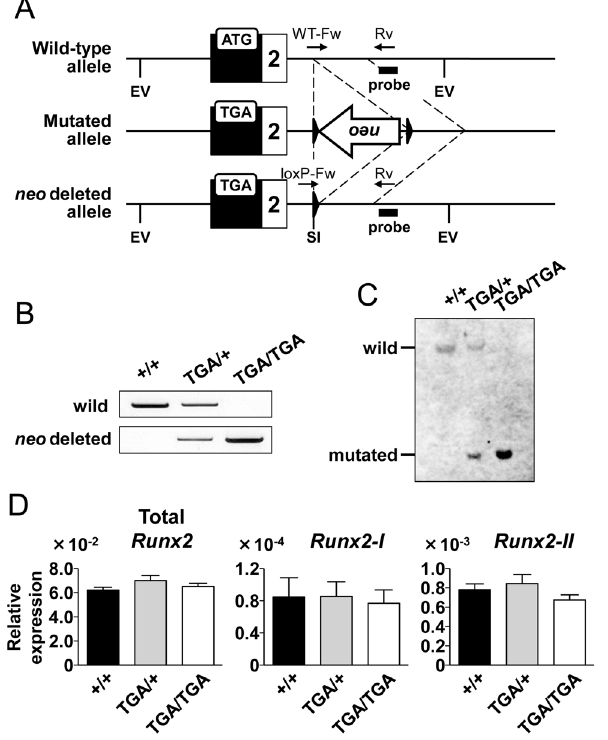
Figure 4. The lethality in Runx2-I neo/neo mice was rescued by neo cassette deletion. Runx2-I neo/ + mice crossed with a Cre deleter mice to remove the neo cassette. (A) Schematic illustration of depletion of the neo cassette. Relevant Eco R V (EV) and Sal I (SI) recognition sites are indicated. (B) Deletion of the neo cassette was confirmed by PCR. The primers depicted in panel (A) were used to detect the wild-type allele (WT-Fw and Rv) and the neo -deleted allele (loxP-Fw and Rv). The PCR products were 1.1 kb in size for both the wild-type and the neo -deleted allele. + / + , wild-type; TGA/ + , heterozygous; TGA/TGA, homozygous. (C) Southern blot analysis using the genome of the indicated Runx2-I - targeted littermates after digestion by Eco R V and Sal I. The membrane was blotted with the probe shown in panel (A). The size of the band was 7.2 kb in the wild-type allele and 1.9 kb in the neo -deleted allele. (D) Fetal calvarial cells were prepared from generated mice. RNA was purified from mice of each genotype and then analyzed by quantitative real-time PCR for expression levels of total Runx2 , Runx2-I , and Runx2-II . Data are representative of three independent experiments and are means 6 SEM ( n =3/group).